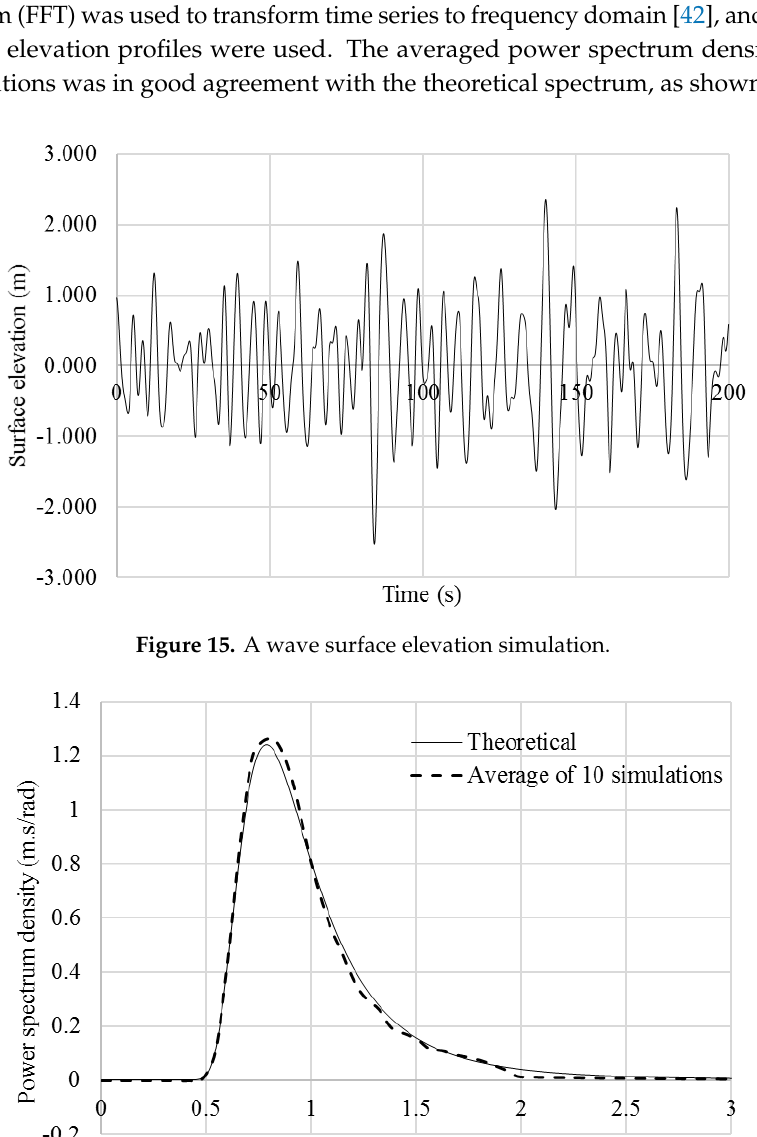
Figure 14. Mode shapes of the jacket-suction bucket piles with soil behavior using Jeanjean’s method ( a ) 1 st mode shape; ( b ) 2 nd mode shape; ( c ) 3 rd mode shape.